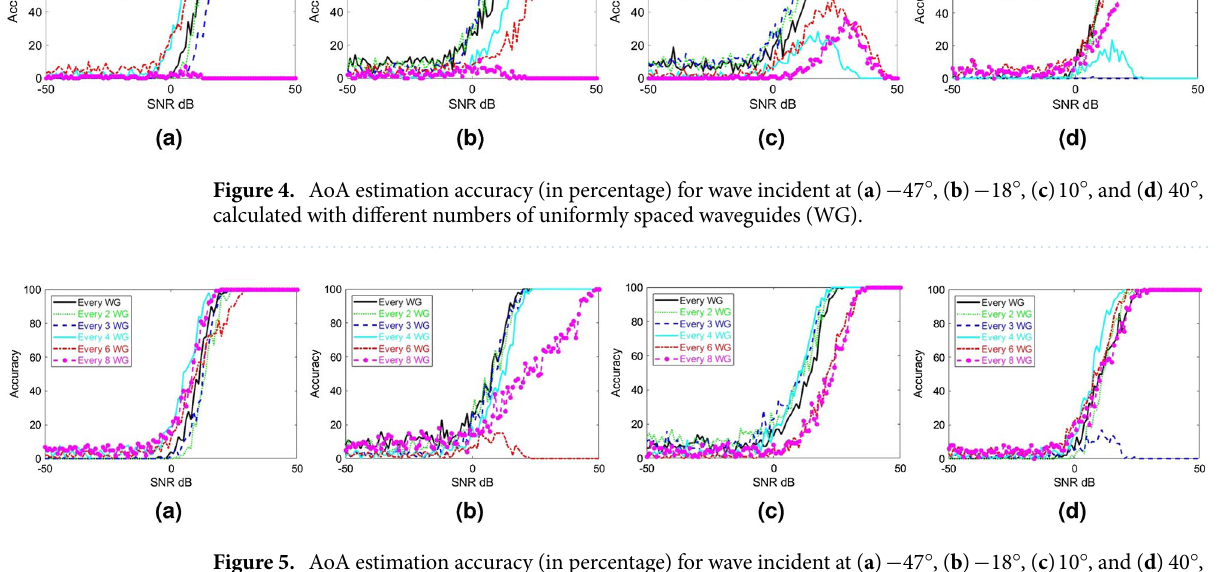
Figure 5. AoA estimation accuracy (in percentage) for wave incident at ( a ) − 47 ◦ , ( b ) − 18 ◦ , ( c ) 10 ◦ , and ( d ) 40 ◦ , calculated with different numbers of nonuniformly spaced waveguides